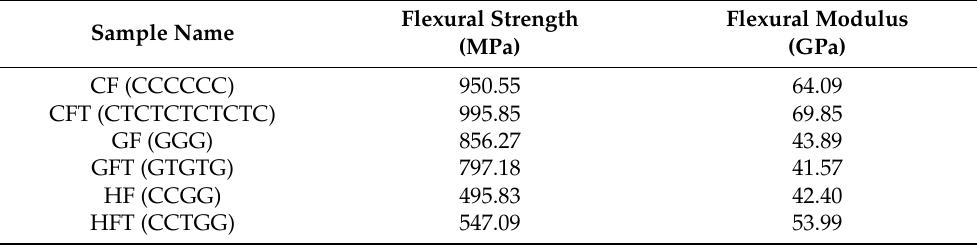
Table 2. CFRP and GFRP composite flexural strength, including hybrid CFRP/GFRP of 1:3 FVF ratio or 1:1 ply ratio, denoted as HF, where C denotes carbon fibre ply G denotes glass fibre and T denotes PA 6,6 veil interlayer.